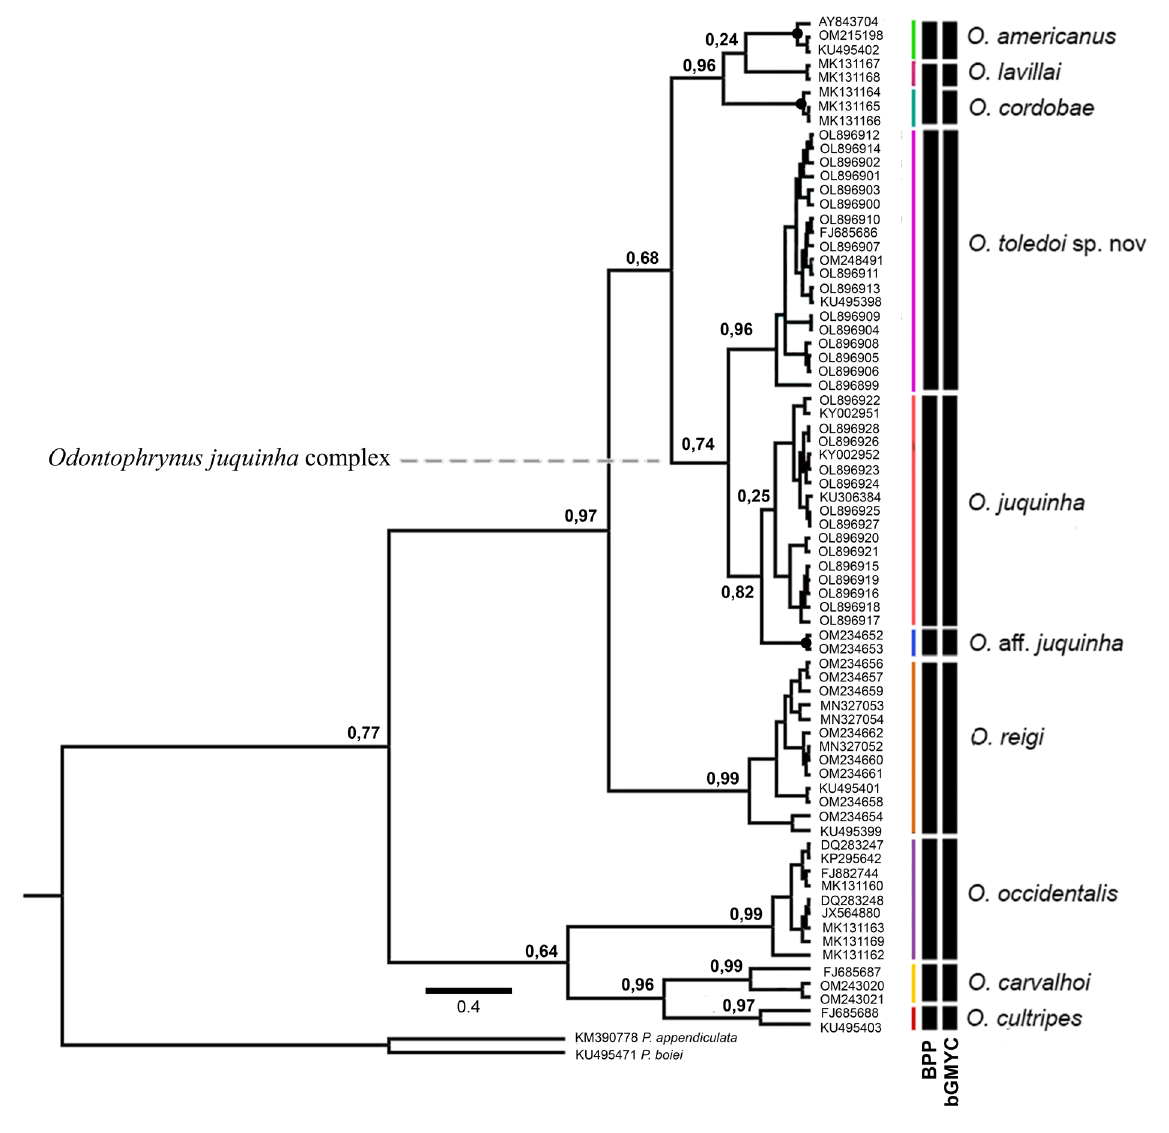
Fig. 9. Phylogenetic analysis of partial sequences of the 16S mtDNA gene of 10 species of the genus Odontophrynus Reinhardt & Lütken, 1862. Nodes are labeled with the Bayesian posterior probability. Scale bar (0.4) in million years. The black bars on the side represent the species delimitated by the bGMYC and BPP methods. The colored bars represents the haplotype groups shown and map in Fig.